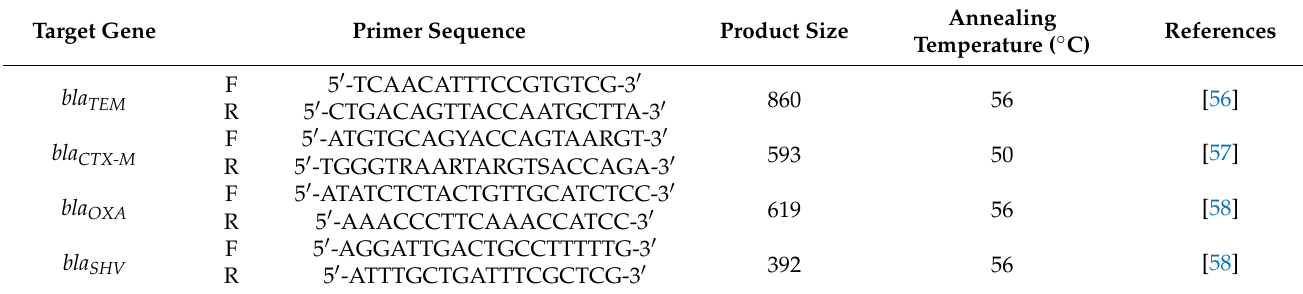
Table 5. Primer used for molecular identification of ESBLs by